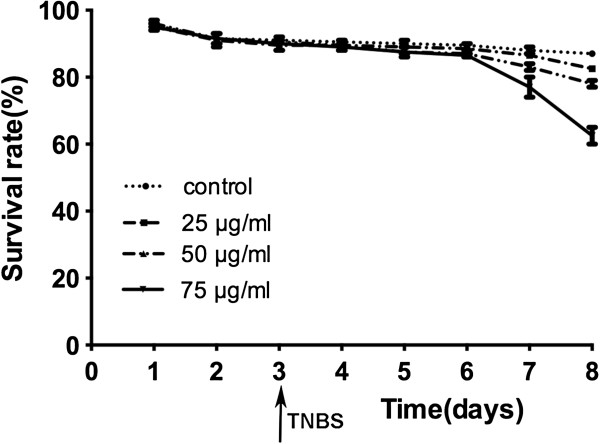
Effect of different 2, 4, 6-trinitrobenzenesulfonic acid (TNBS) concentrations (0, 25, 50 and 75 μg/ml) in the cumulative survival rate. Zebrafish were exposed to TNBS from 3 days post fertilization (dpf). Results are representative of three independent experiments. Values are presented as mean ± SEM.